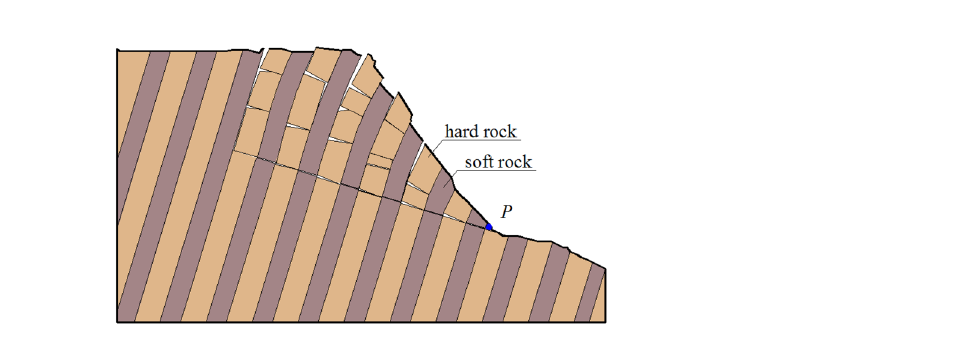
Figure 2. Schematic diagram for deformation and failure state of soft–hard-interbedded anti-inclined rock slope.